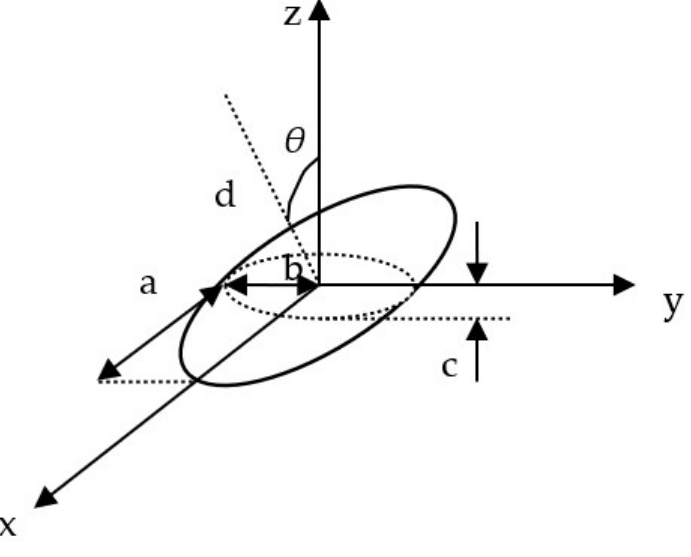
Figure 1. Geometry of a scatterer.